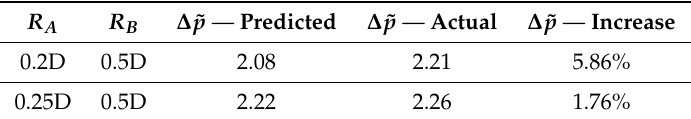
Table 3. Normalised pressure losses ∆ ˜ p , at Re = 250, calculated by solving the velocity field in the full combined geometry, compared with the predicted loss, calculated by simply summing the normalised pressure losses from the component velocity fields (see Section 4.1). R A R B ∆ ˜ p — Predicted ∆ ˜ p — Actual ∆ ˜ p — Increase